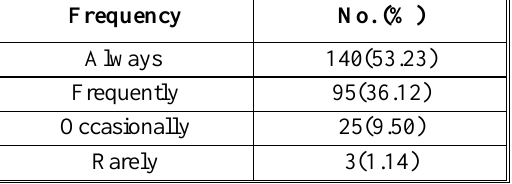
Table 4. Degree of attention of the patients to